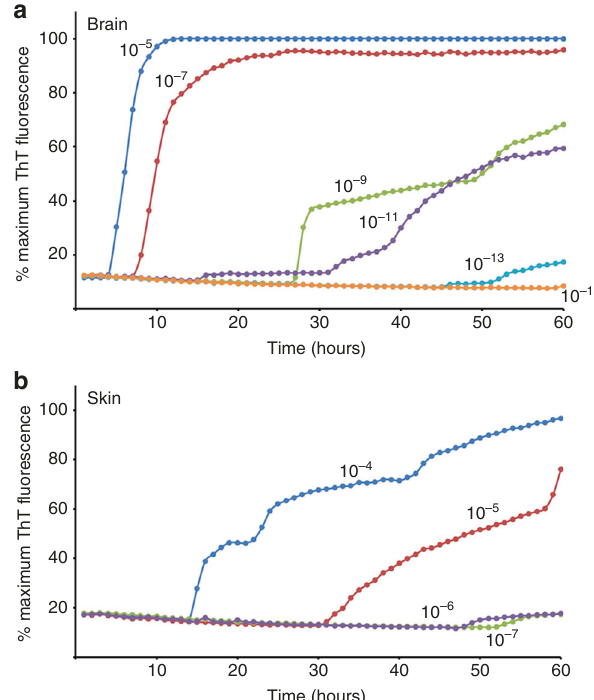
Fig. 6 RT-QuIC end-point titration of brain and skin samples of Tg40h mice. a The brain homogenate from the sCJDMM1-inoculated Tg40h mice was diluted serially until 10 − 15 and seeded for RT-QuIC assay. b The skin homogenate from the sCJDMM1-inoculated Tg40h mice was serially diluted until 10 − 7 and seeded for RT-QuIC assay. Similar results were observed in two-independent experiments. Fluorescence readings from replicate wells were averaged ( y -axis) and plotted as a function of time ( x -axis). The RT-QuIC spectra are the representative of three-independent experiments with three skin samples from CJD-infected Tg40 mice at 4 wpi, while RT- QuIC assay detected prion-seeding activity only at 20 wpi (Fig. 8). The reason for the difference in Tg40 mice is not clear, but may